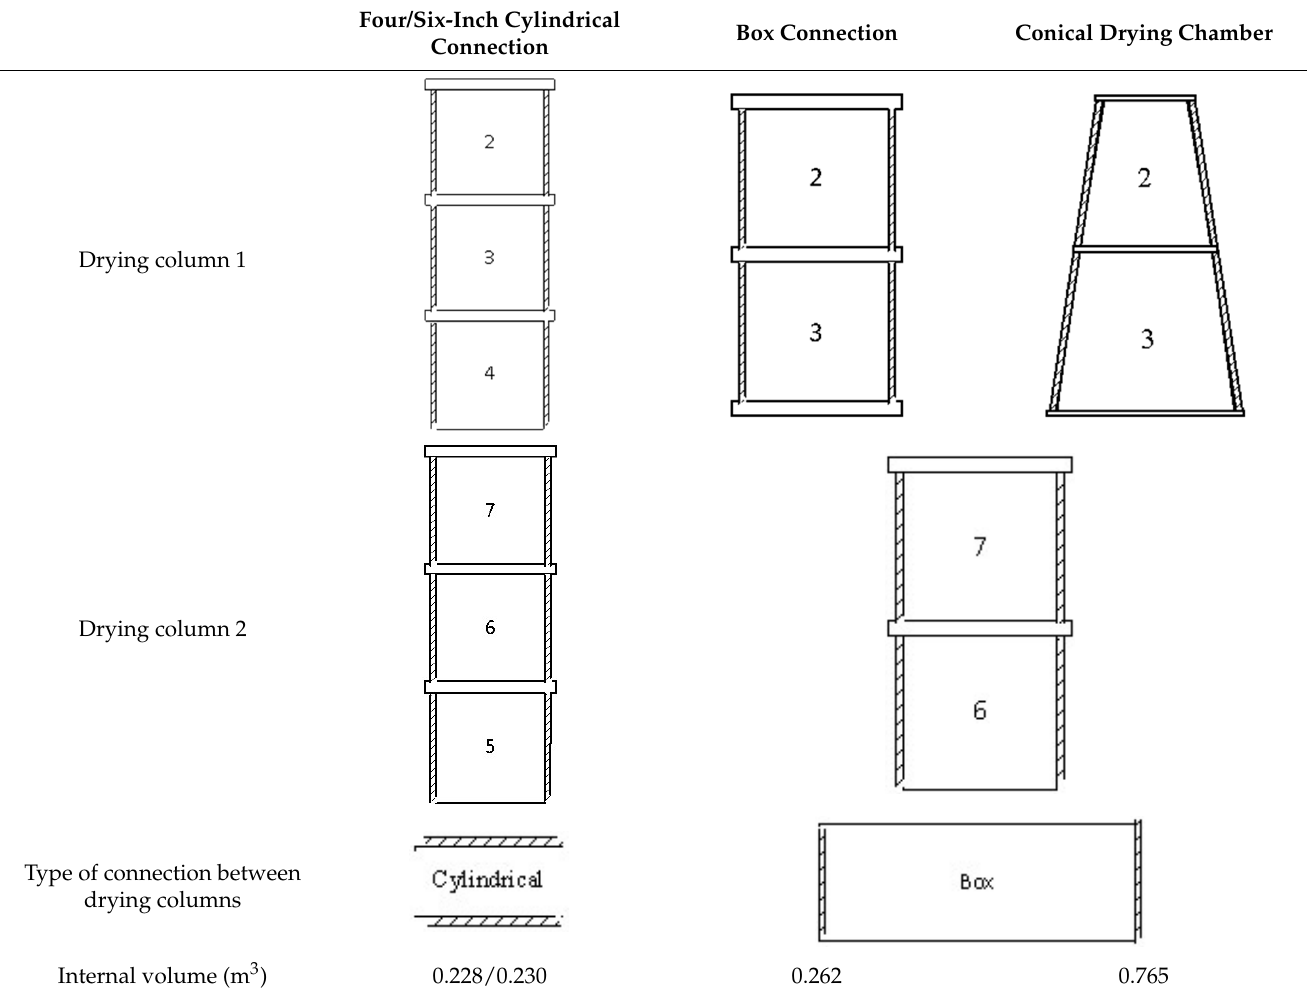
Figure 3. Spray dryer with conical drying chamber and box connection (Design 4). Table 1. Key differences between the designs and the internal volumes of the different designs.